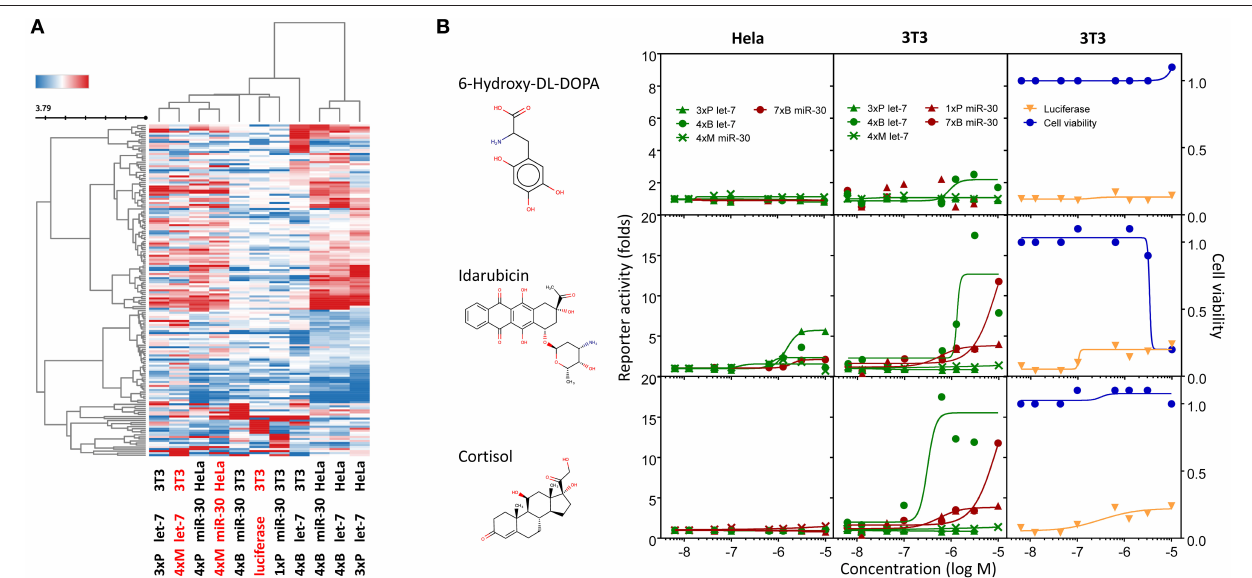
FIGURE 7 | Compounds affecting miRNA reporter assays in a miRNA-independent way are common. Clustering analysis of all dose-response experiments ( Table 2 ) represented by the pIC50 values of 163 compounds. Red font color indicates reporters lacking engineered miRNA binding sites. (B) Examples of activities of three compounds related to previously published results. Graphs depict activities of different reporter assays in HeLa and 3T3